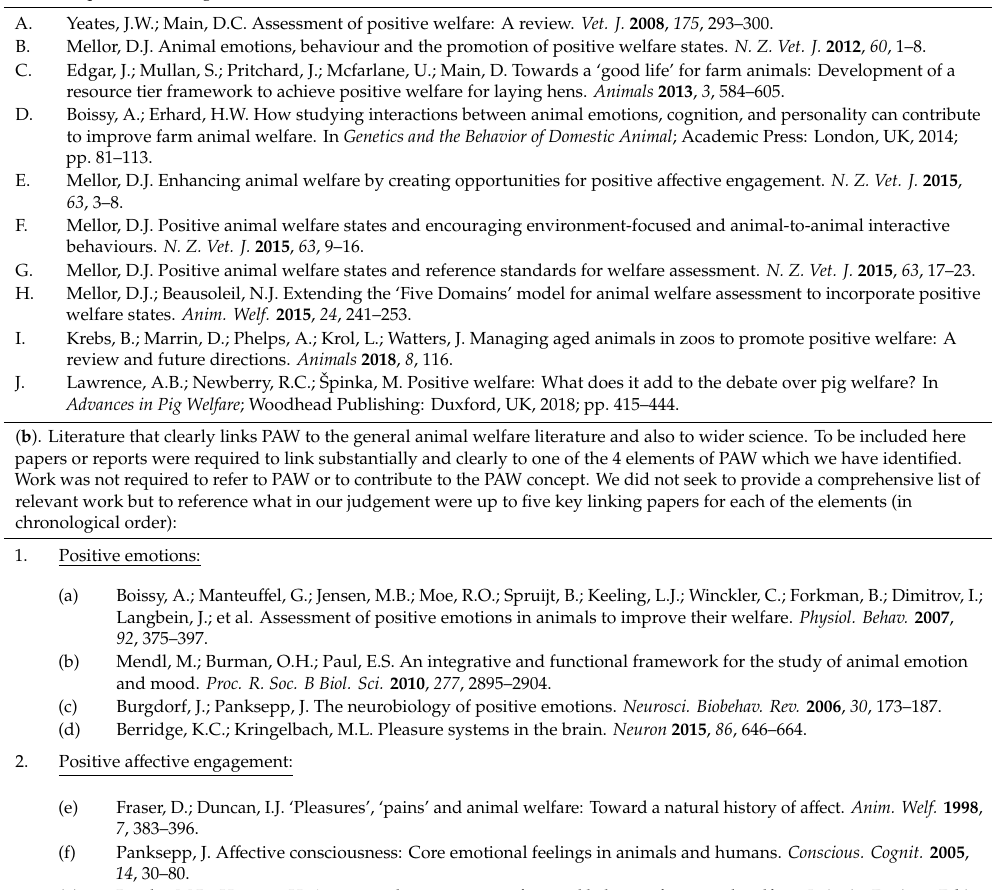
Table 1. ( a ) A chronologically organized list of the core positive animal welfare (PAW) literature; ( b ) a list of literature that links to PAW organized chronologically under the 4 features: positive emotions; positive a ff ective engagement; quality of Life; happiness. Explanations for the inclusion criteria for these lists are contained in the Table. The lettering for this table is used in Figure 1 and cross-referenced against the main reference list in Section